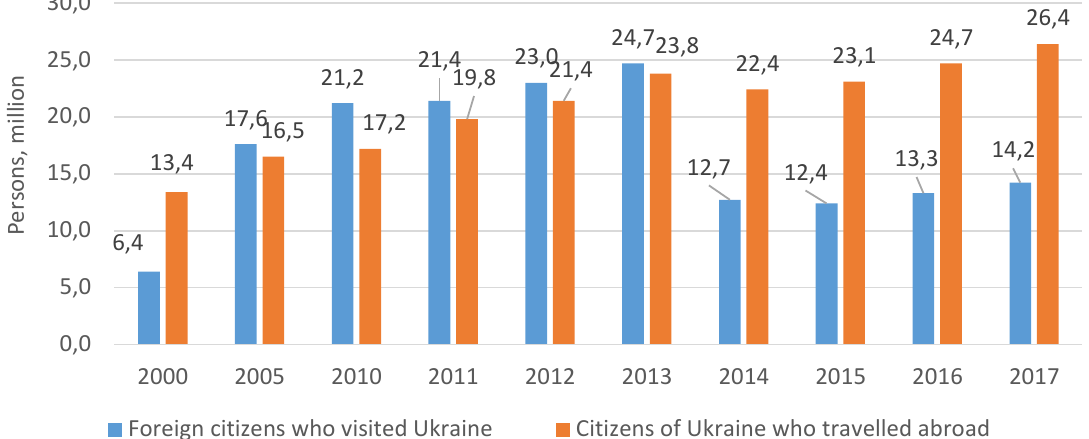
Figure 1. Tourist flows of Ukraine,